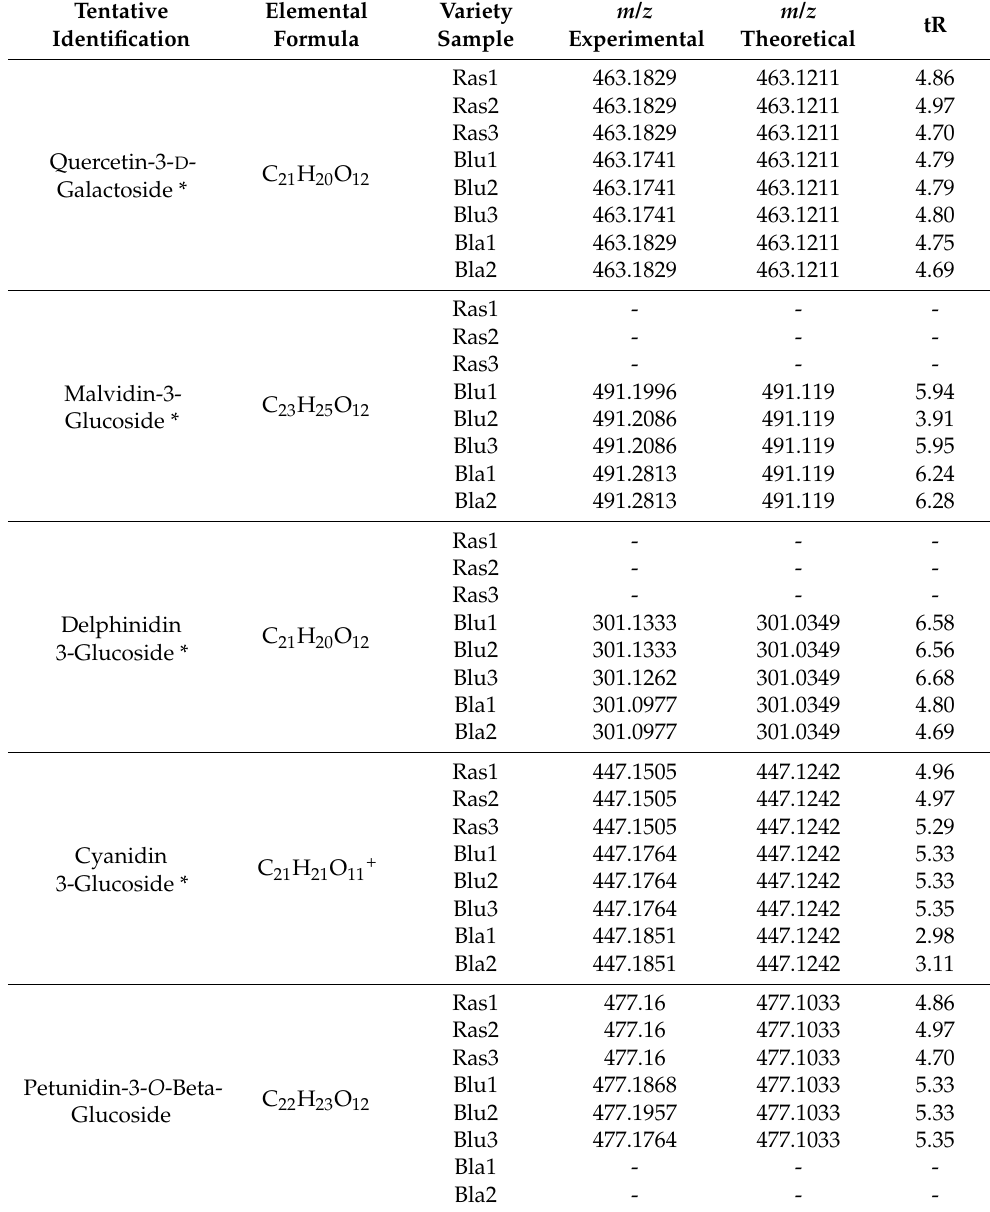
Table 2. Tentative identification of metabolite compounds in extracts of eight varieties of Mexi- can